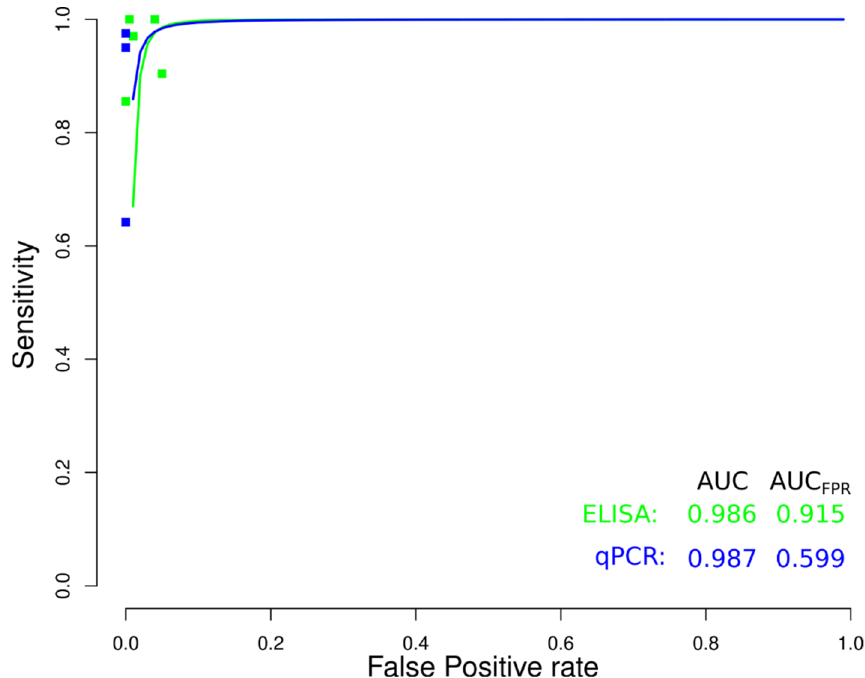
Figure 10. Meta-analysis of diagnostic test accuracy analysis. Summary receiver operating curve (sROC) plot of false positive rate and sensitivity. Comparison between ELISA and qPCR methods in the diagnosis of acute Chagas disease.